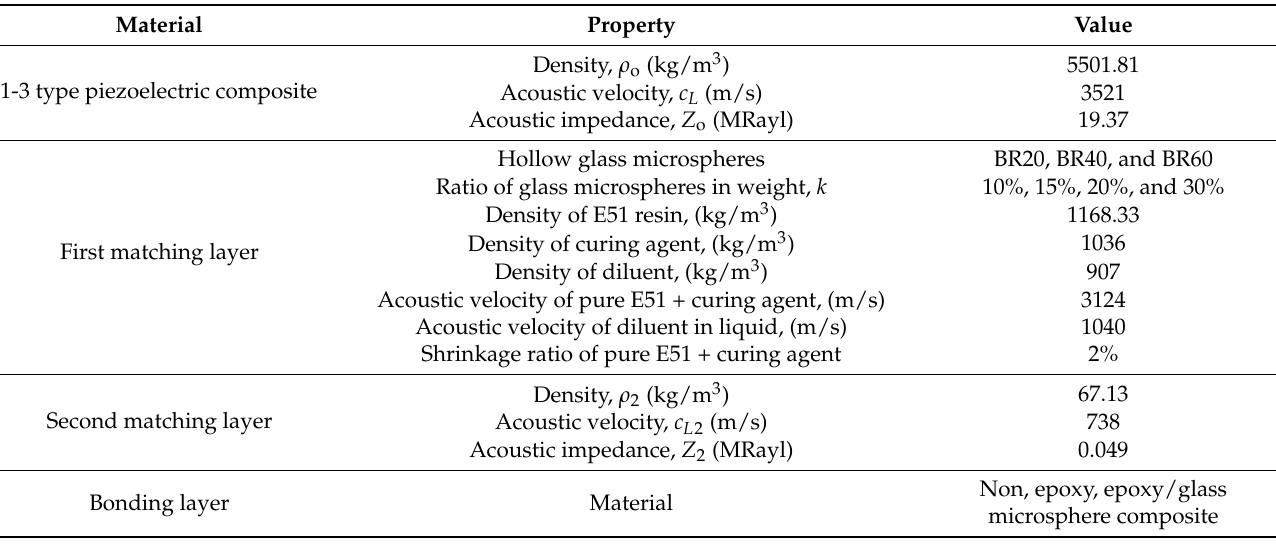
Table 1. List of experiment parameters.